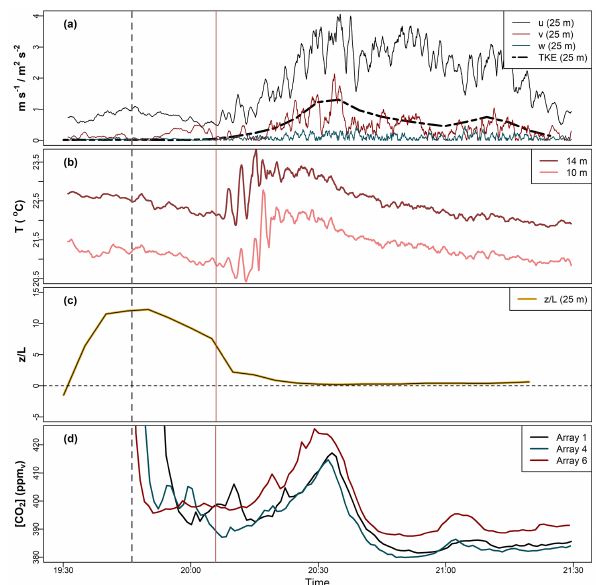
Figure C1. Time series after shutdown on 27 August 2019 of (a) the magnitude of the velocity vector components (ms − 1 ) and TKE (m 2 s − 2 ) at z = 25m, (b) T ( ◦ C), (c) z/L (where L is the Obukhov length; Sect. 2.5), and (d) [CO 2 ]. The dashed grey vertical line in- dicates the shutdown time, and the solid red line is the approximate arrival time of the warm microfront described in the paragraph be- low. The high-resolution measurements in panels (a) – (c) are from on Met 1, at the southern edge of the BIFoR FACE facility (Fig. 1 and Sect. 2.1). Panels (a) and (b) show 1min rolling